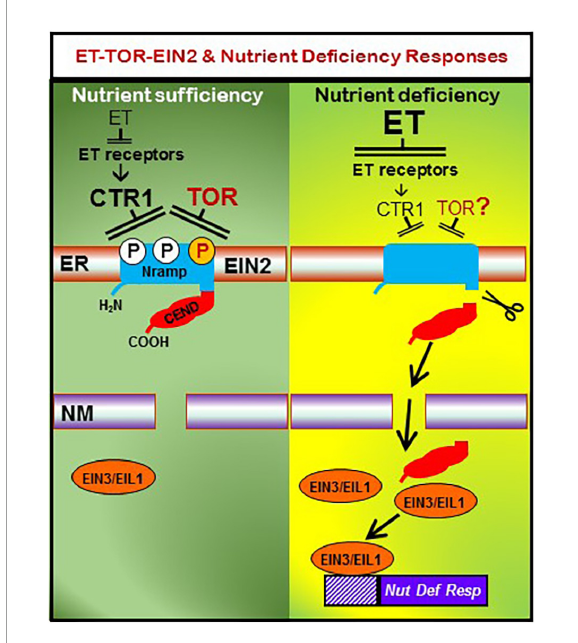
FIGURE2 Working model to explain the possible roles of ethylene (ET) and TOR in the activation of nutrient deficiency responses through EIN2. Left: in the absence of ethylene (ET), which occurs under nutrient sufficiency, the CTR1 kinase phosphorylates EIN2 at Ser645/Ser924, preventing the cleavage and translocation of CEND into the nucleus. In parallel, under nutrient sufficiency, the TOR kinase phosphorylates EIN2 at Thr657, preventing the cleavage and translocation of CEND into the nucleus. Right: under nutrient deficiency, ET production is enhanced and, once perceived by ET receptors, CTR1 is inactivated, thus resulting in dephosphorylation of EIN2 and its cleavage. CEND is then translocated into the nucleus, where results in more EIN3/EIL1 binding to target genes and ultimately transcription activation of ET responsive genes, like those related to nutrient deficiency responses. Similarly, under nutrient deficiency, TOR is inactivated, which could also result in dephosphorylation of EIN2 and its cleavage and translocation into the nucleus. Whether the influence of TOR on EIN2 plays a key role in the activation or deactivation of nutrient deficiency responses deserves further research. ER, Endoplasmic Reticulum; NM, Nuclear Membrane. Based on Angulo et al. (2021) and Fu et al.